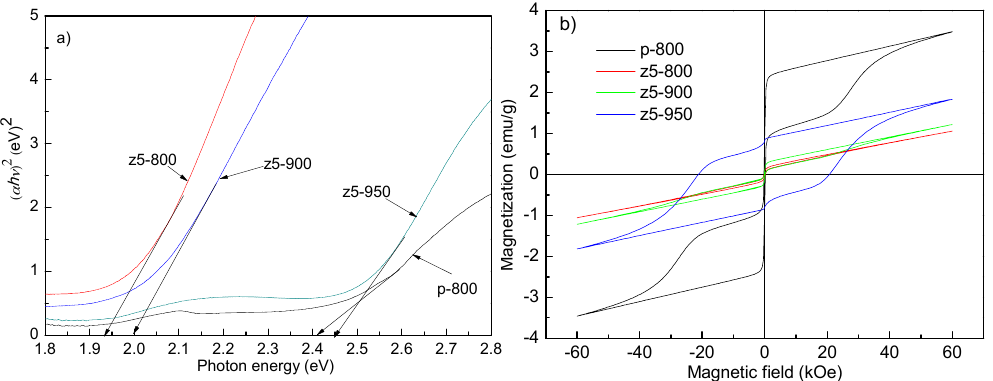
Figure 3. ( a ) Optical band gaps and ( b ) room-temperature magnetic hysteresis loops for p-800, z5-800, and z5-950 samples.